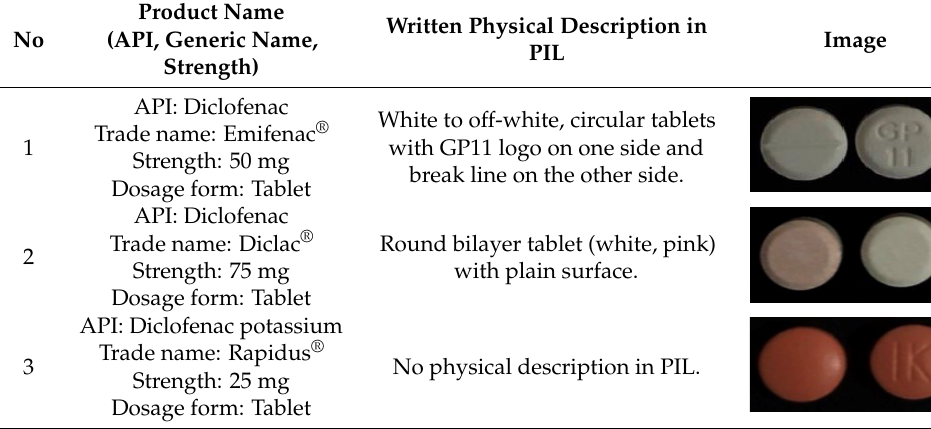
Table 6. Practical Table 6. Practical examples. Table 6. Practical examples. Table 6. Practical examples. Table 6. Practical examples. Table 6. Practical examples. Table 6. Practical examples.